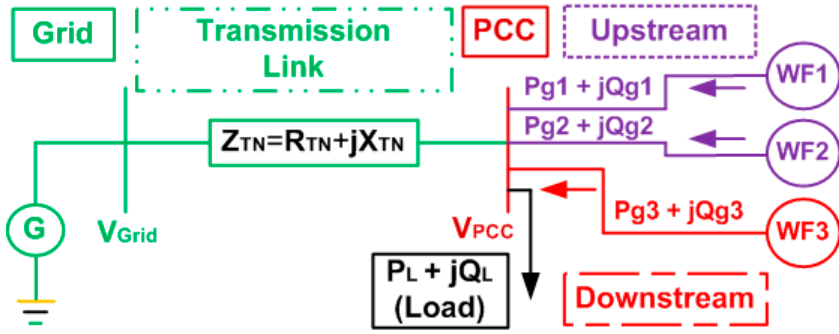
Figure 2. Equivalent of an LSWF-based model with grid integration issues.